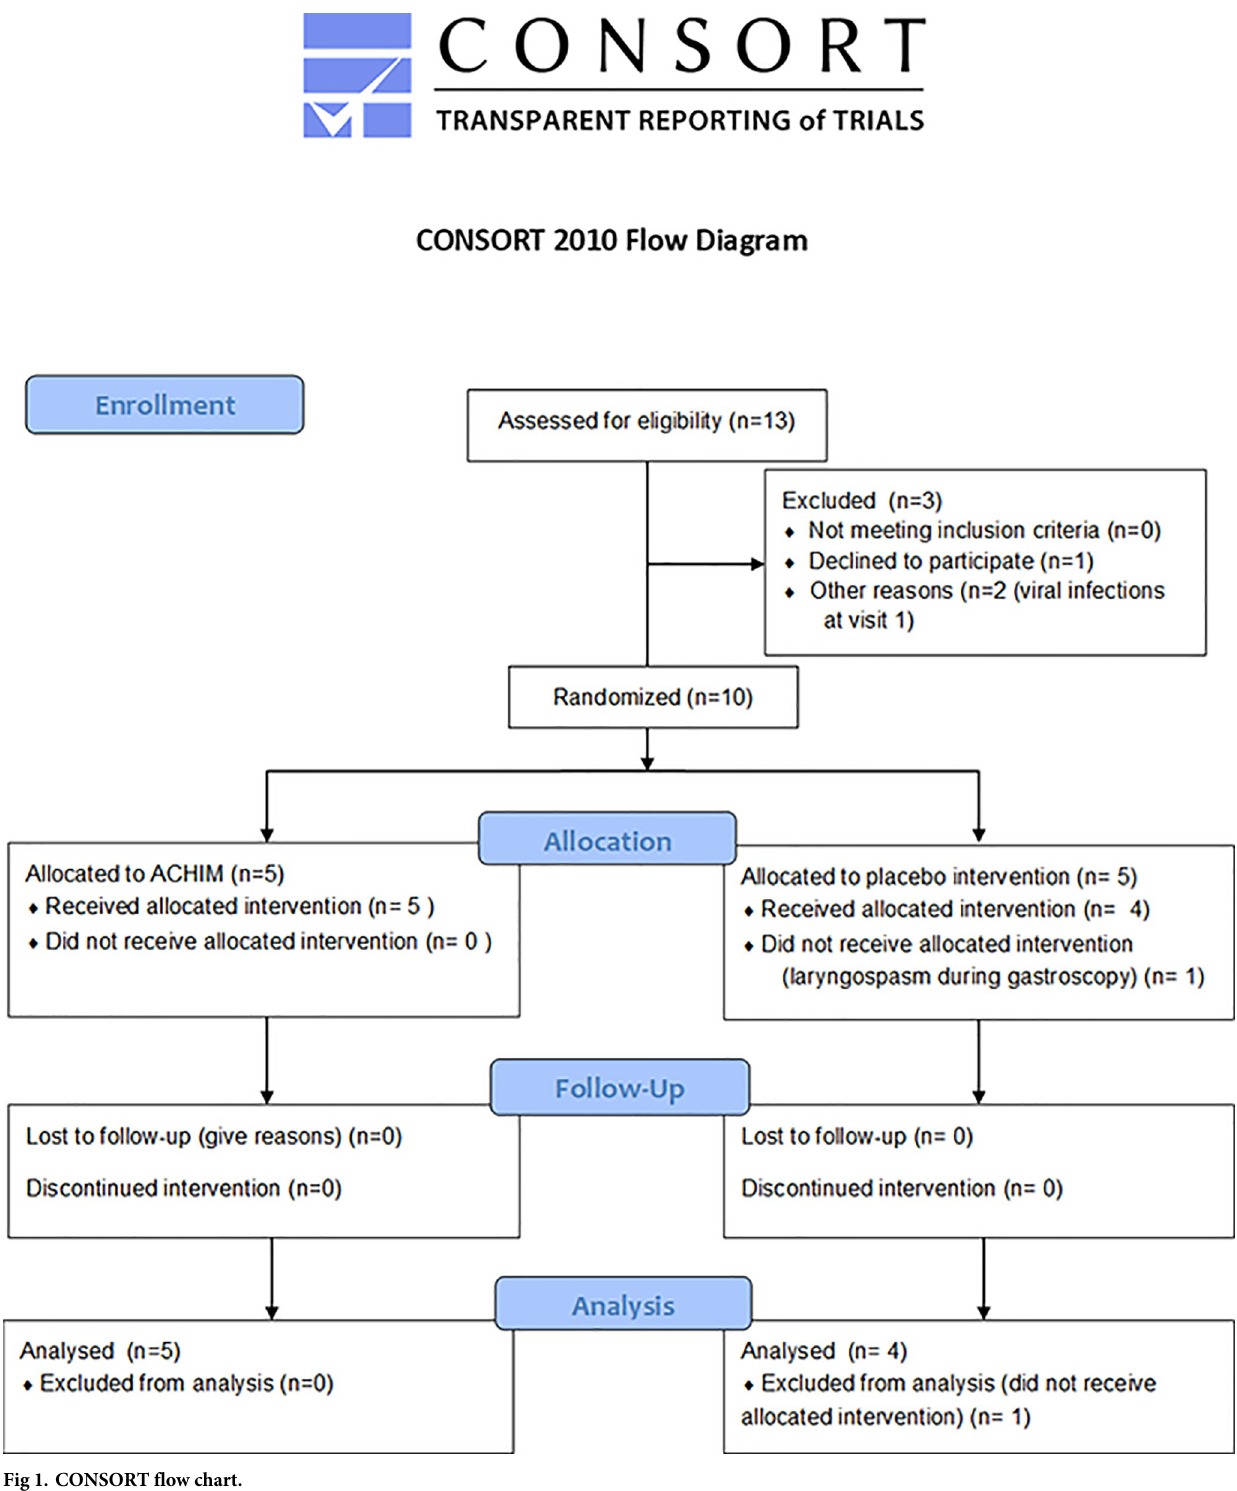
Fig 1. CONSORT flow chart.